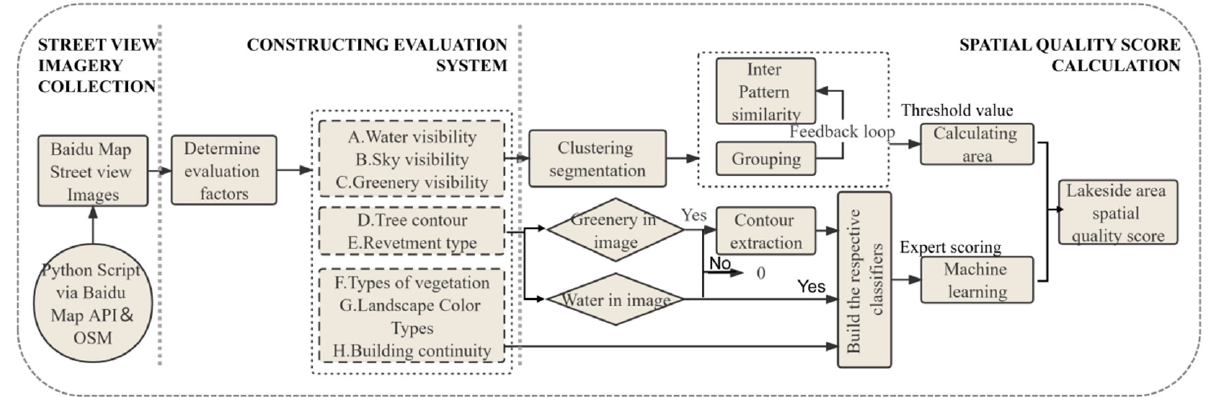
Figure 4. Technical route of evaluation index.